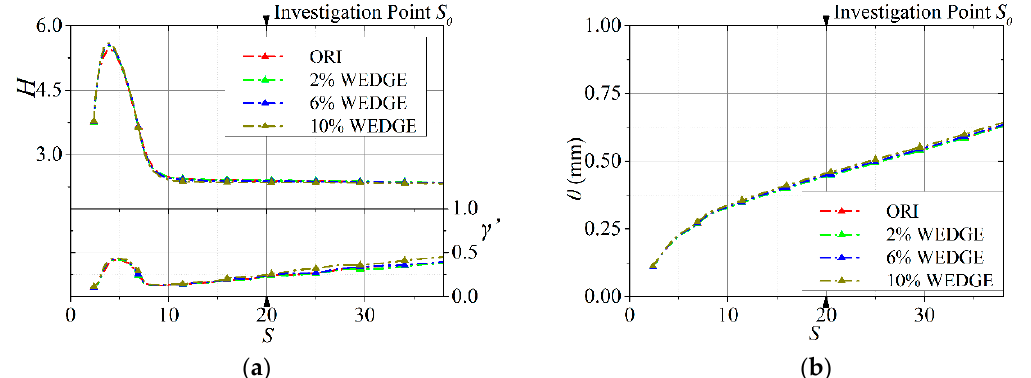
Figure 8. The WEDGE of Ellip.LE at Tu = 5%: ( a ) the boundary layer shape factor and normal average turbulence intermittency; ( b ) the momentum thickness along aerofoils.